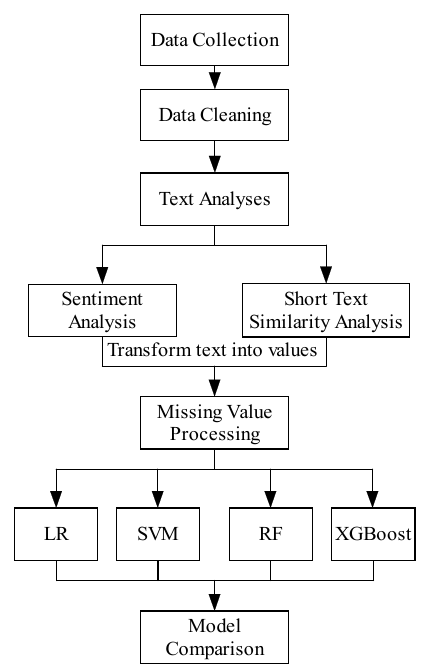
Figure 1. Research methodology framework.